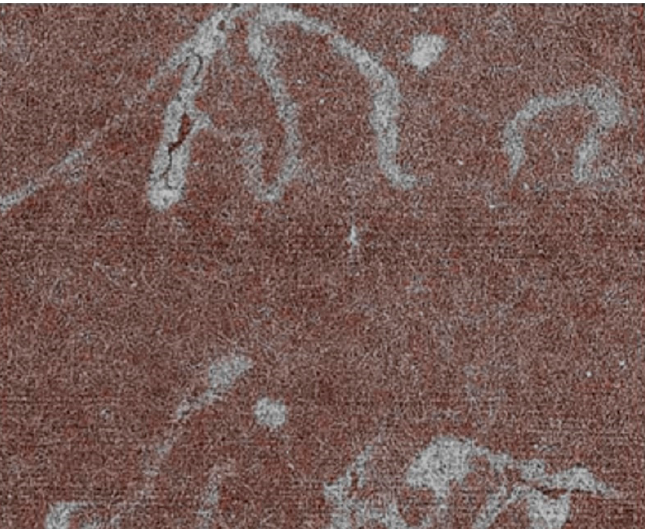
Figure 22. Radiography reads ancient handwritings with “iron gall” inks without requiring the opening of books [29–31].